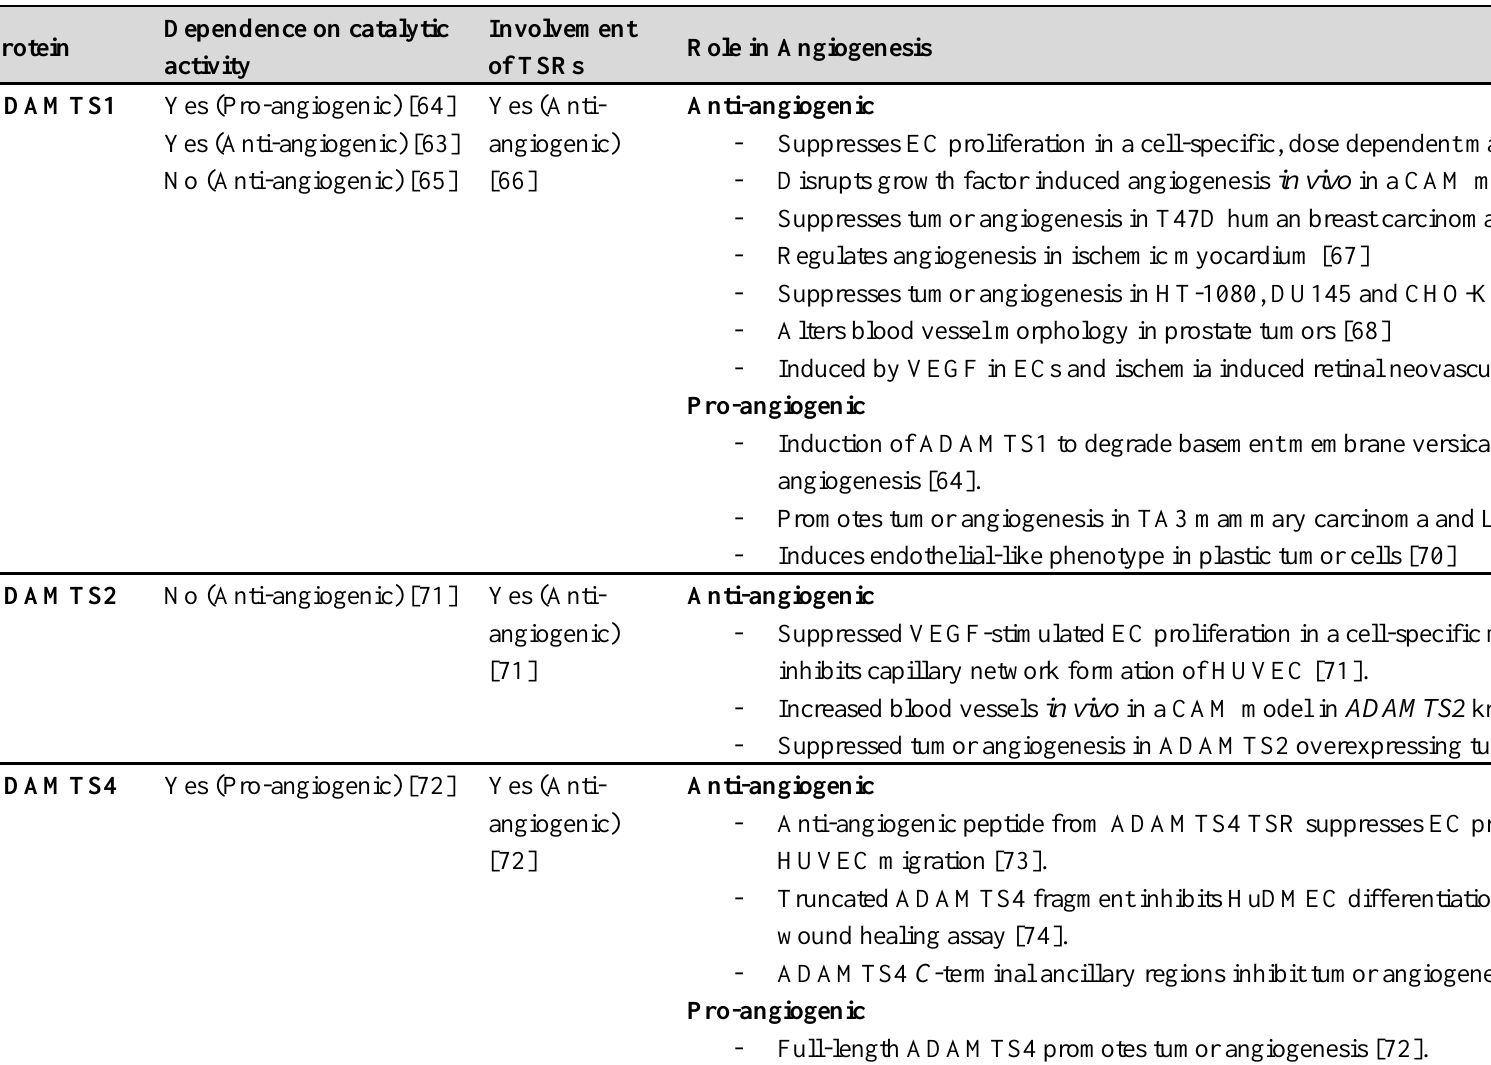
Table 2. ADAMTS role in